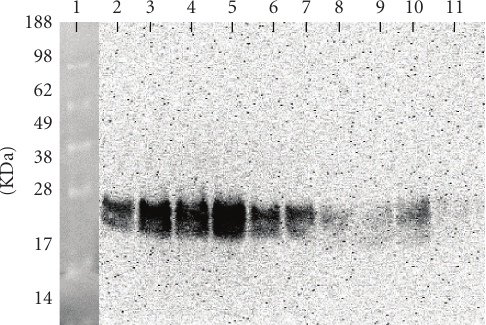
Figure 2: Screening of puromycin resistant clones in Sf9 cells co- transfected with pIE1/153A (V4) expression plasmid carrying hIL-7 gene and pBmA-pac carrying puromycin resistance gene. Cells were placed in medium containing puromycin at a final concentration of 5 μ gmL − 1 for 3 weeks. Lane 1: protein marker. Lanes 2–11: polyclones Sf9hIL-7G, Sf9hIL-7E, Sf9hIL-7F, Sf9hIL-7A1, Sf9hIL- 7B4, Sf9hIL-7D5, Sf9hIL-7H, Sf9hIL-7C1-2, Sf9hIL-7C1-3, and Sf9hIL-B4-1, respectively.